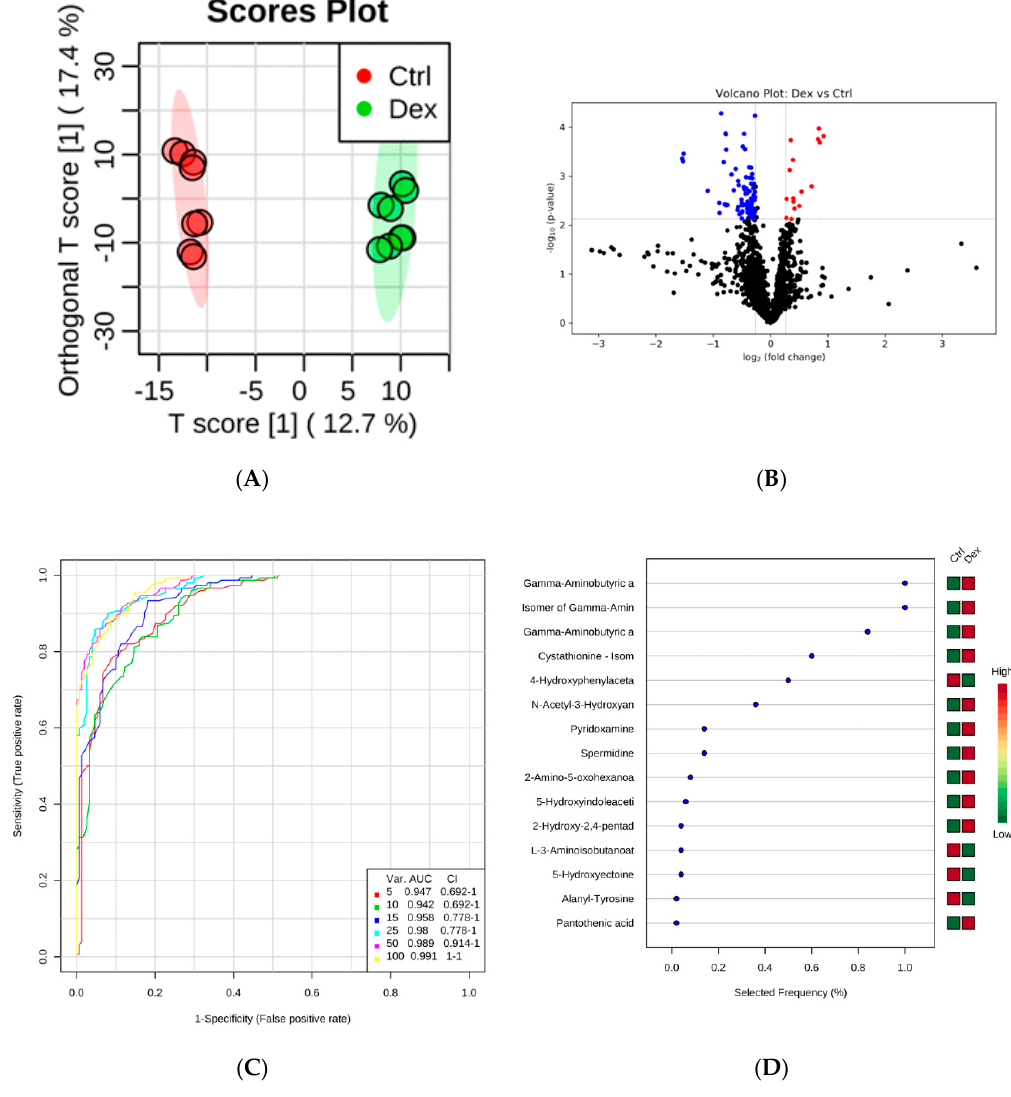
Figure 2. Rat heart tissue submetabolomic profile after prolonged treatment with dexamethasone (Dex). ( A ) OPLS-DA score plot ( Q 2 = 0.861, R 2 = 0.987) shows a clear separation between the healthy group (Ctrl, n = 5) and Dex-treated groups ( n = 5). Tissue samples were run on LC-MS in duplicate. ( B ) Volcano plot shows the statistically significant altered metabolites (FDR-corrected p -value < 0.05, and FC > 1.2 or < 0.83). The levels of 89 metabolites were down-regulated (blue) and 16 were up-regulated (Red) in Dex-treated rats compared to controls. ( C ) The ROC curve was generated by the OPLS-DA model, with AUC values calculated from the combination of 5, 10, 15, 25, 50, and 100 metabolites. ( D ) Frequency plot shows 15 positively identified metabolites.